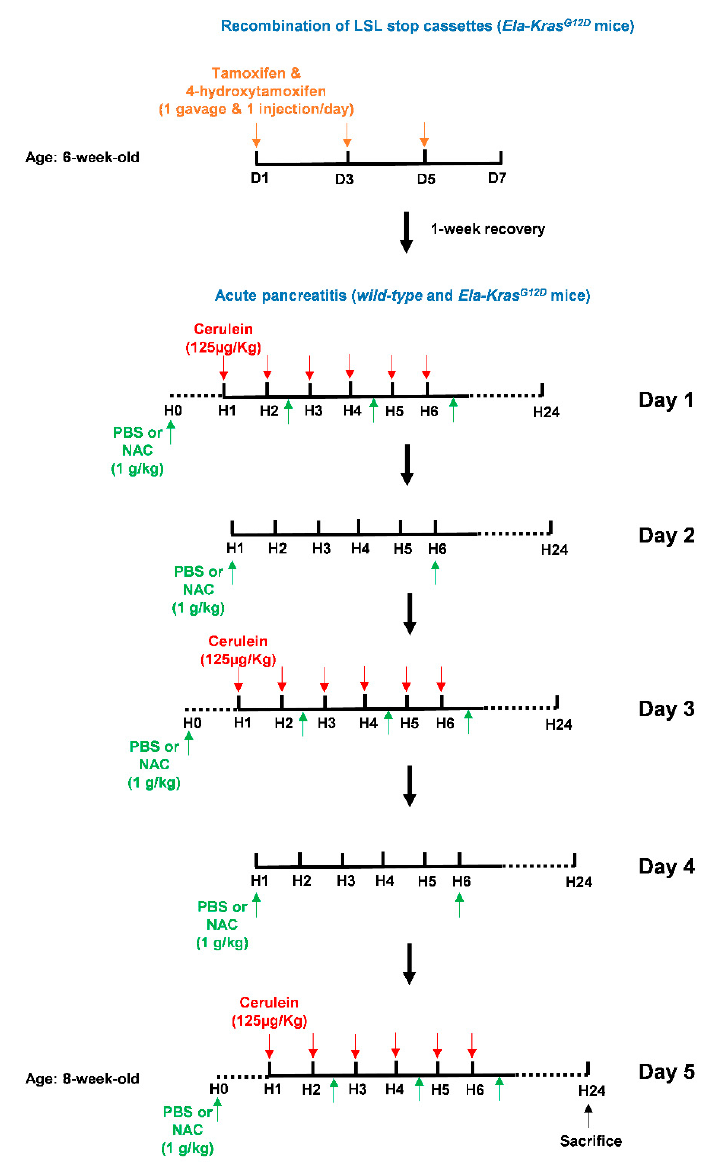
Figure 3. Illustration of the tamoxifen and cerulein regimens as well as NAC treatments. To initiate pancreas tumorigenesis, 6-week-old Ela-Kras G12D mice were first treated once a day with tamoxifen (gavage) and 4-hydroxytamoxifen (subcutaneous injection), on day (D) 1, 3 and 5 (orange arrows), to induce recombination of the LSL stop cassette and allow the expression of Kras G12D from its endogenous locus. After tamoxifen injections, mice recovered for 1 week. To induce acute pancreatitis, wild-type ( WT) or tamoxifen-treated Ela-Kras G12D mice started a 5-day acute pancreatitis regimen. On day (D) 1, 3 and 5, mice received 6-daily intraperitoneal cerulein injections (red arrows) at a frequency of 1 injection/h (H). Cerulein diluted in a PBS volume of 100-150 µL was injected at a concentration of 125 µg/kg/injection. On day (D) 1, 3 and 5, mice received 4 intraperitoneal injections of NAC as indicated (green arrows). On day (D) 2 and 4, mice received 2 intraperitoneal injections of NAC as indicated (green arrows). Each NAC dose was 1 g/kg in a volume of 100–150 µL diluted in PBS. For vehicle-treated mice, intraperitoneal injections of 100–150 µL PBS were given instead of NAC. Mice were then sacrificed by cervical dislocation after 24 h.